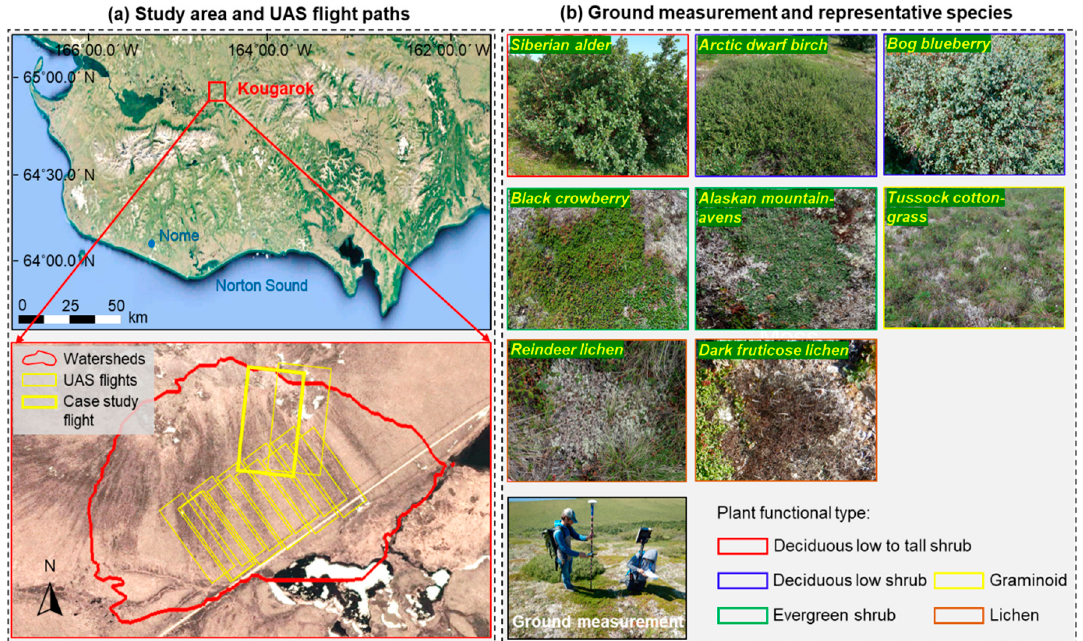
Figure 2. ( a ) Location of the Kougarok study site and Osprey flights performed in the 2018 field campaign. The bold yellow rectangle indicates the flight used for the case study. The red boundary shows the watershed selected for the Next-Generation Ecosystem Experiments (NGEE) Arctic project.